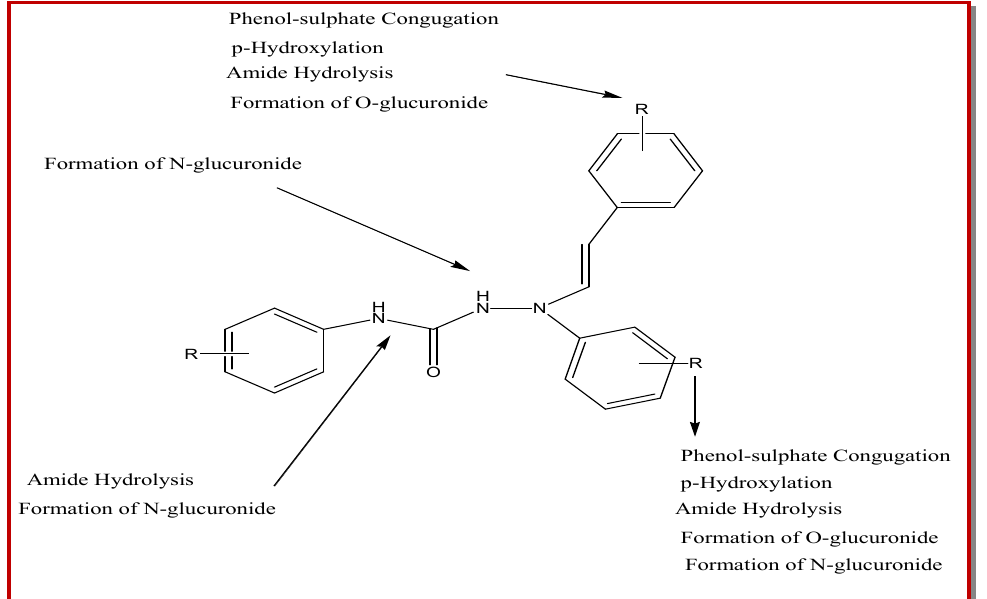
Figure 2: In silico m etabolism of the